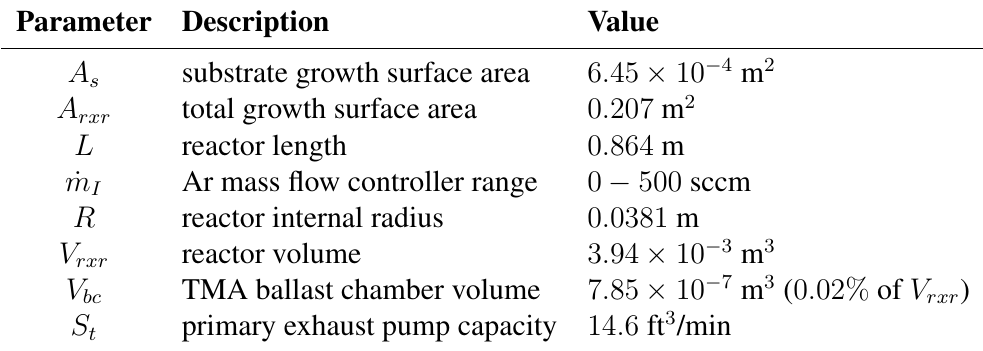
Table 1. Reactor dimensions and primary system component design parameters of the ALD reactor system shown in Figure 3. TMA,